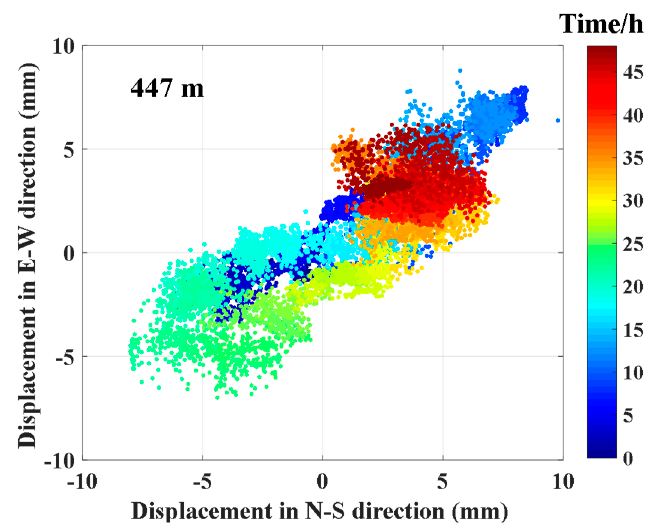
Figure 10. Displacement trajectory of the roof (from 5 July 2017 to 7 July 2017). Appl. Sci. 2020 , 10 , x FOR PEER REVIEW